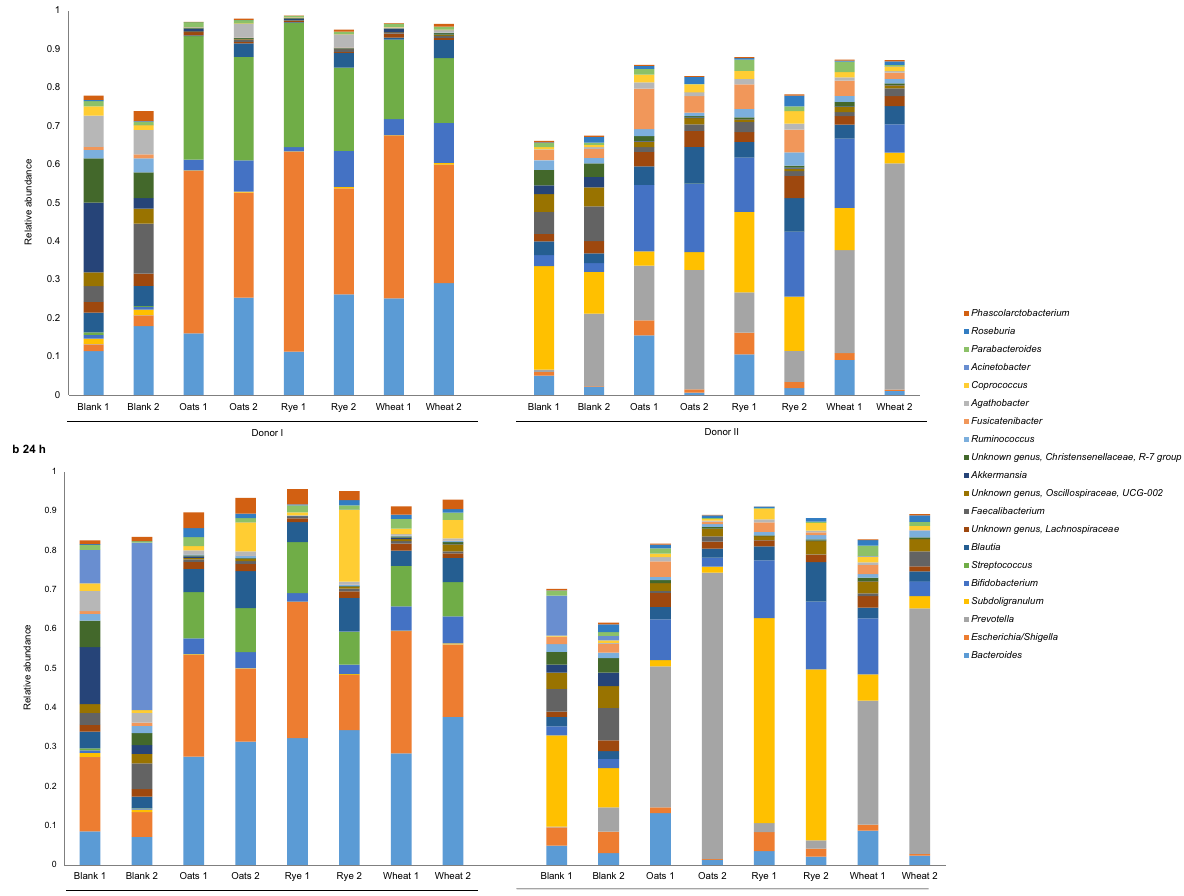
Figure 2. The 20 most abundant microbial genera in ( a ) 8 h fermentation samples, and ( b ) 24 h fermentation samples. Each bar represents mean of replicates (n = 2) from one fermentation experiment occasion (1 and 2). Blank indicates samples without substrate, and oats, rye and wheat indicate samples with fermentation